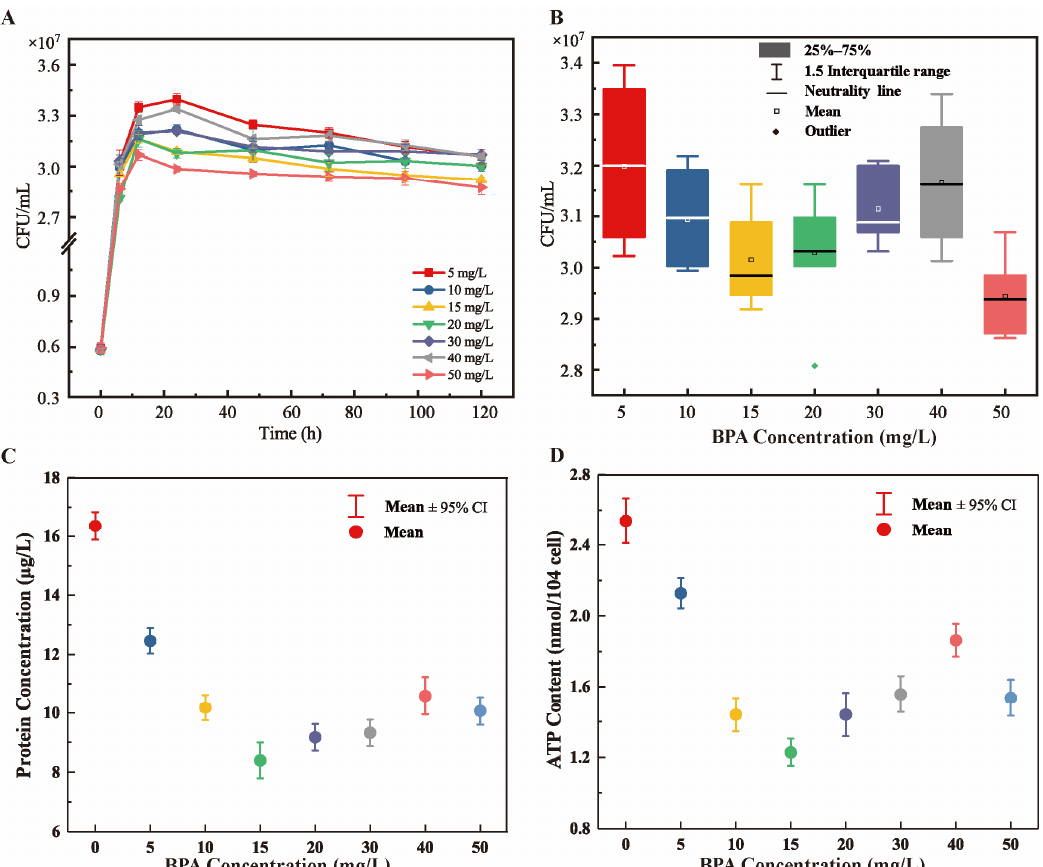
Figure 2. Inhibition of R-001 by different concentrations of BPA. ( A ) Strain growth. ( B ) Variations in CFU value. ( C ) Changes in protein concentration. ( D ) Changes in ATP